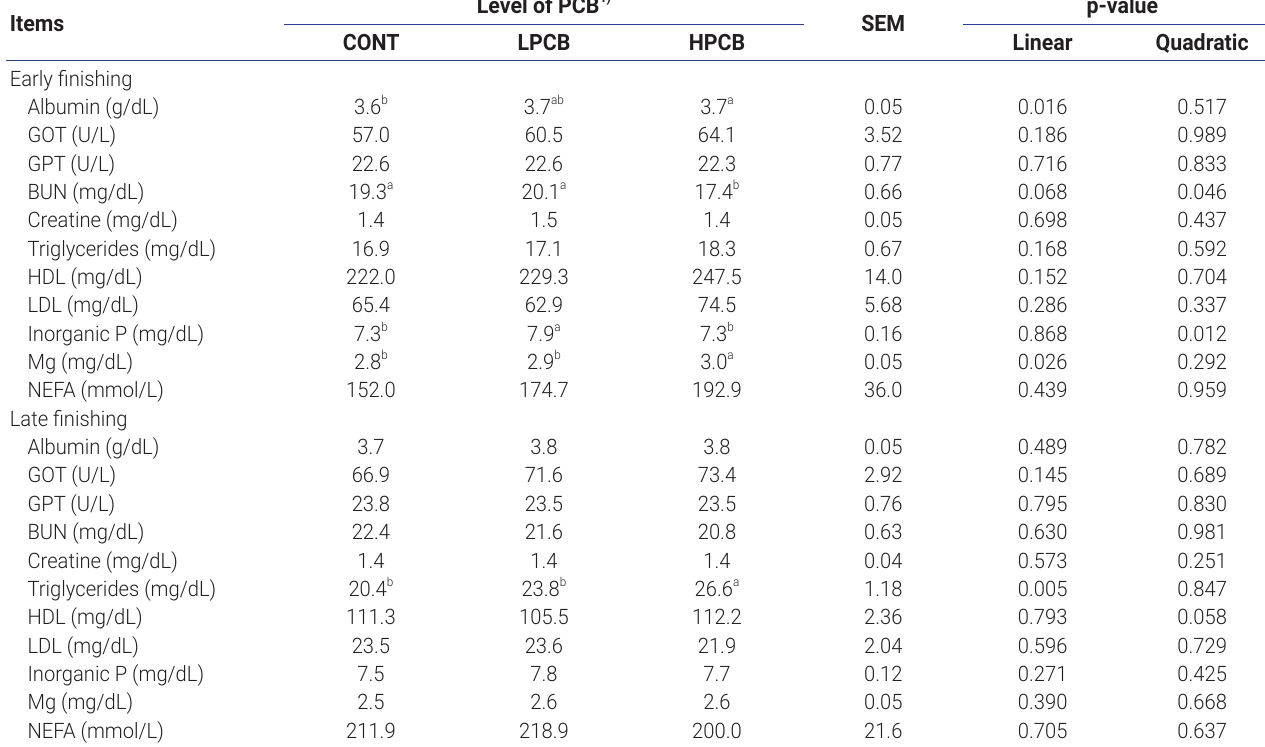
Table 4. Effects of pineapple cannery by-product on serum blood parameters of early finishing Hanwoo steers Items